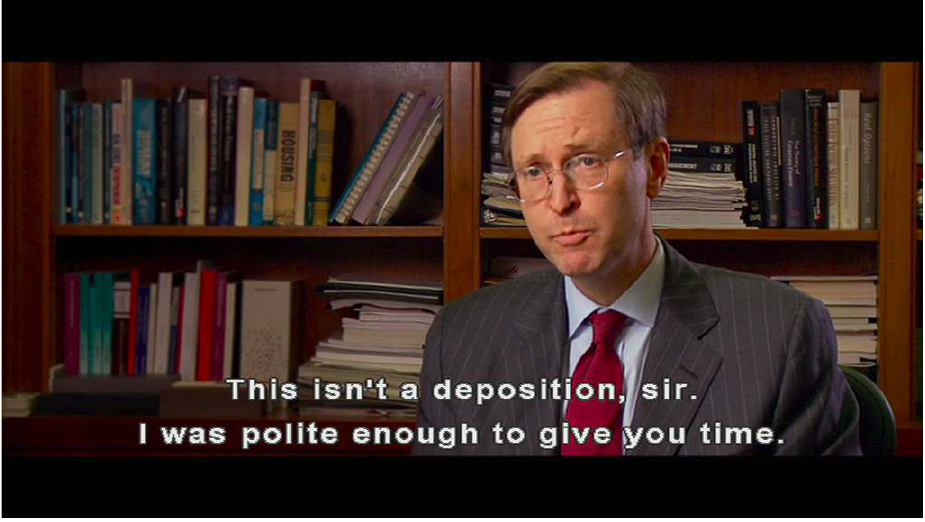
Source: Inside Job , by Charles Ferguson (screen